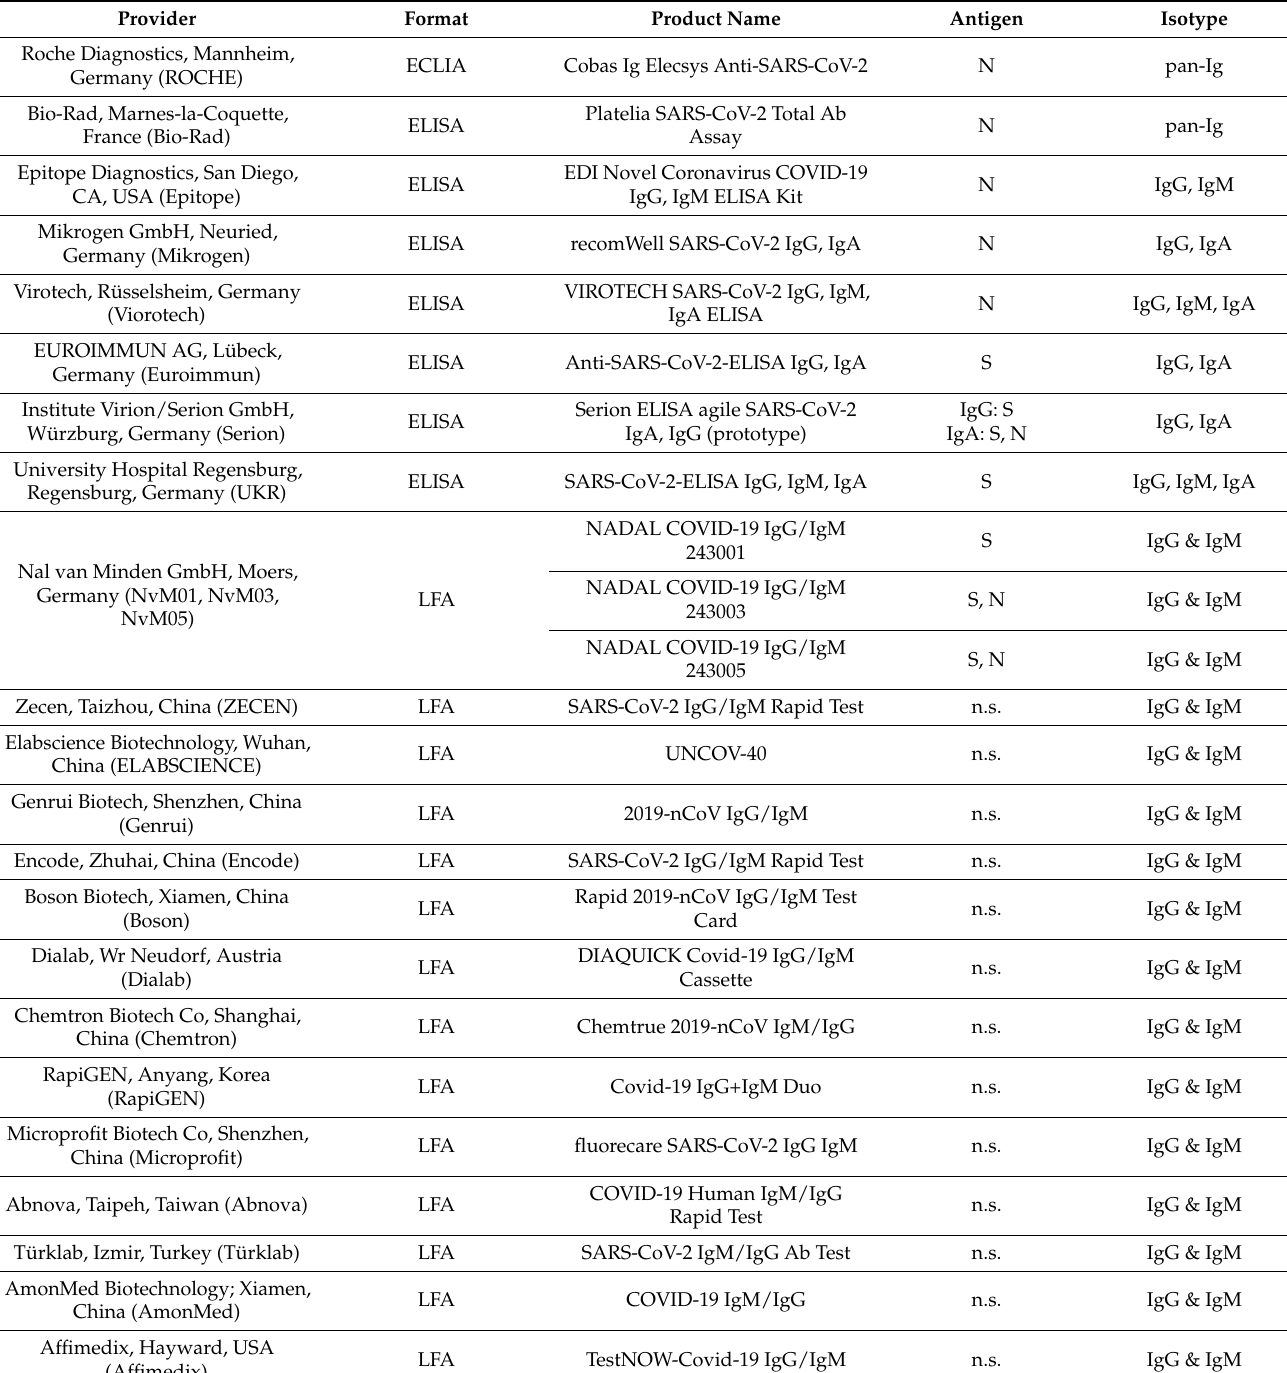
Table 1. Tests used within this